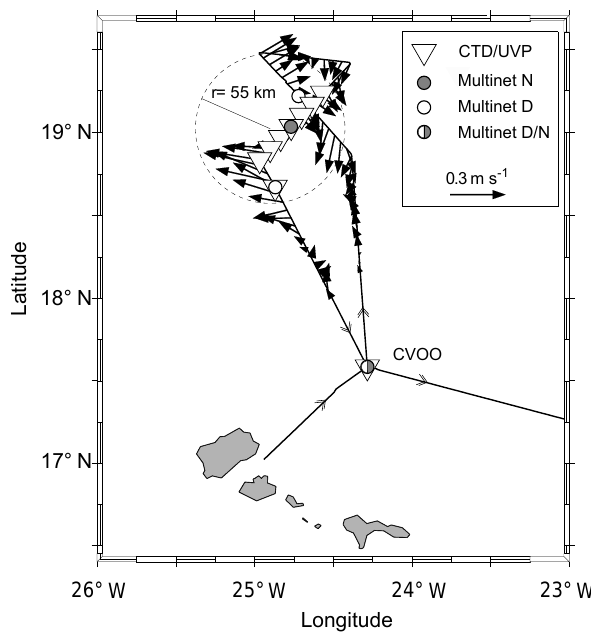
Figure 1. Cruise track (M105, only shown from 17 to 20 March 2014) with horizontal current velocities (arrows) and CTD/UVP sampling positions (triangles) as well as multinet sta- tions (grey circles are night, empty circles are day). Large dashed circle indicates the estimated radius of the eddy based upon current